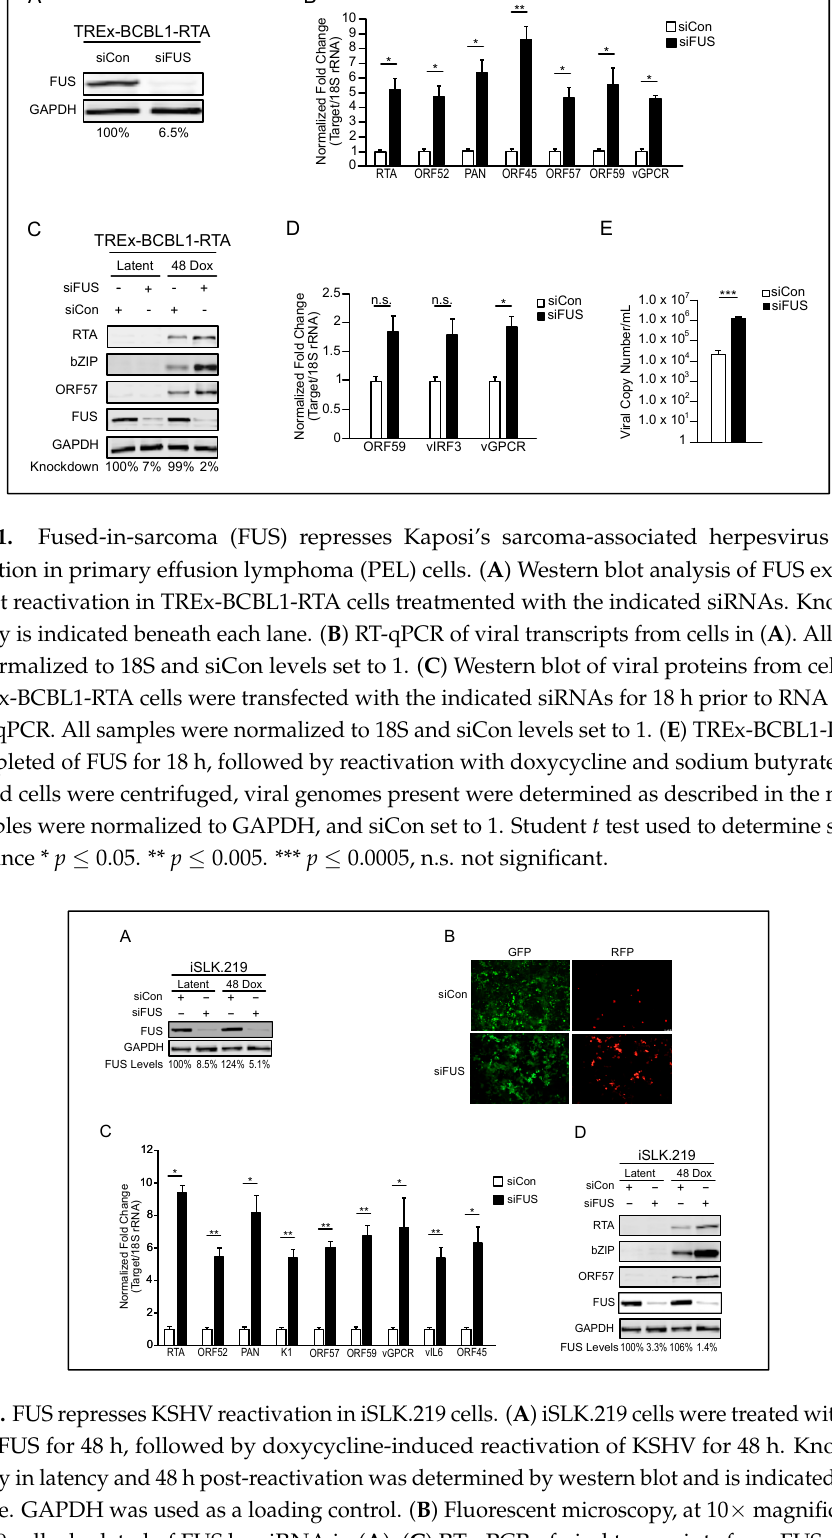
Figure 1. Fused-in-sarcoma (FUS) represses Kaposi’s sarcoma-associated herpesvirus (KSHV) reactivation in primary effusion lymphoma (PEL) cells. ( A ) Western blot analysis of FUS expression 48 h post reactivation in TREx-BCBL1-RTA cells treatmented with the indicated siRNAs. Knockdown